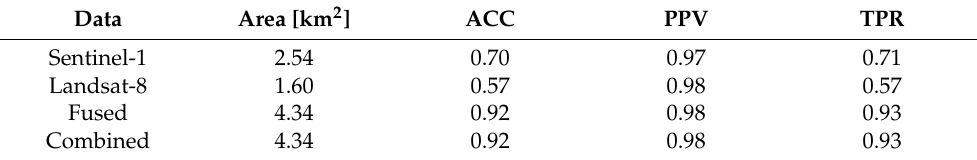
Figure 7. Combined outcome from all the classifiers: true positive (red area), false positive (yellow area) and false negative (blue area). Chã das Caldeiras is the summit caldera, inside which the active cone of Pico do Fogo rises up. This figure was generated using Google Earth. Table 5. Areal extent of lava flow field of the 2014 – 2015 Fogo eruption estimated by machine learning classifiers using S1, L8, fused and combined data. The performance indices ACC, PPV, and TPR, ranging between 0 (worst case) and 1 (best case), quantify the goodness of fit with the actual lava flow area.